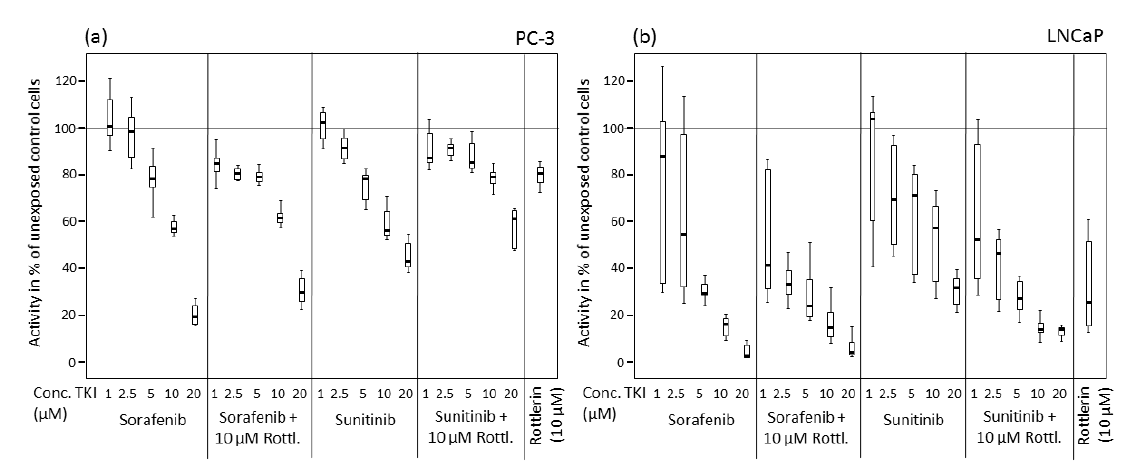
Figure 1: Viability of prostate cancer cells exposed to various concentrations of sorafenib and sunitinib with/without rottlerin (10 µM), determined in an MTT assay. ( a ) PC-3 cell line; ( b ) LNCaP cell